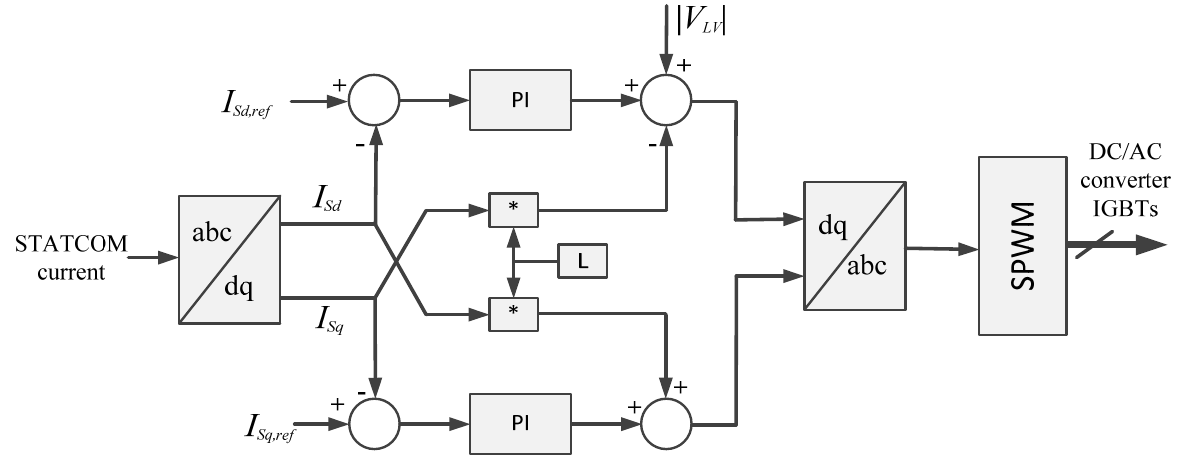
Figure 13. Block diagram of the inner vector control technique implemented in the STATCOM. PI, proportional plus